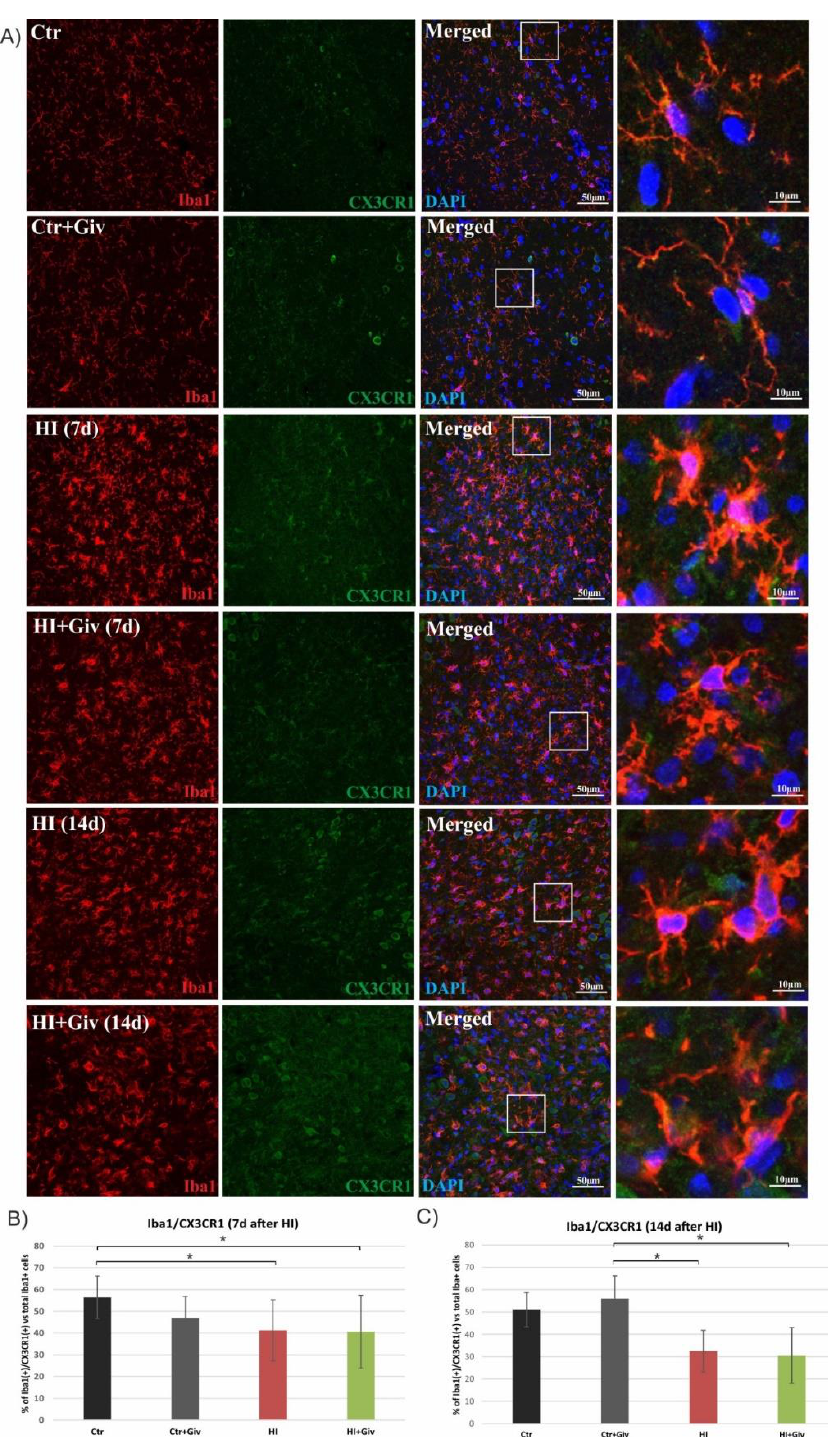
Figure 7. Hypoxia-ischemia decreased the level of CX3CR1 localized on microglia. Sections from ipsilateral (hypoxic-ischemic) hemispheres 7 and 14 days after HI were stained for anti-Iba1 antibody-labeled microglia (red) and for CX3CR1 (green) ( B ). Nuclei were labeled with DAPI (blue). ( A ) Representative photomicrographs show double-labeled cells (yellow) in the cortex. Enlargements present areas marked in rectangles. Number of Iba1/CX3CR1-positive cells quantified in the brain cortex area (0.36 mm 2 ) 7 days ( B ) and 14 days ( C ) after HI. Note the significant decrease in CX3CR1 on microglia at both investigated time points after HI regardless of Givinostat administration. The values are means ± SD from five animals per group. One-way ANOVA indicates significant differences between the investigated experimental groups: * p <